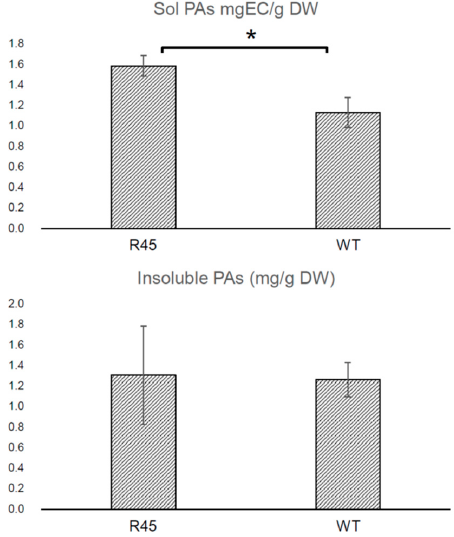
Figure 4. Contents of soluble and insoluble PAs measured in R45 and R108 (WT) seeds (* p < 0.05).